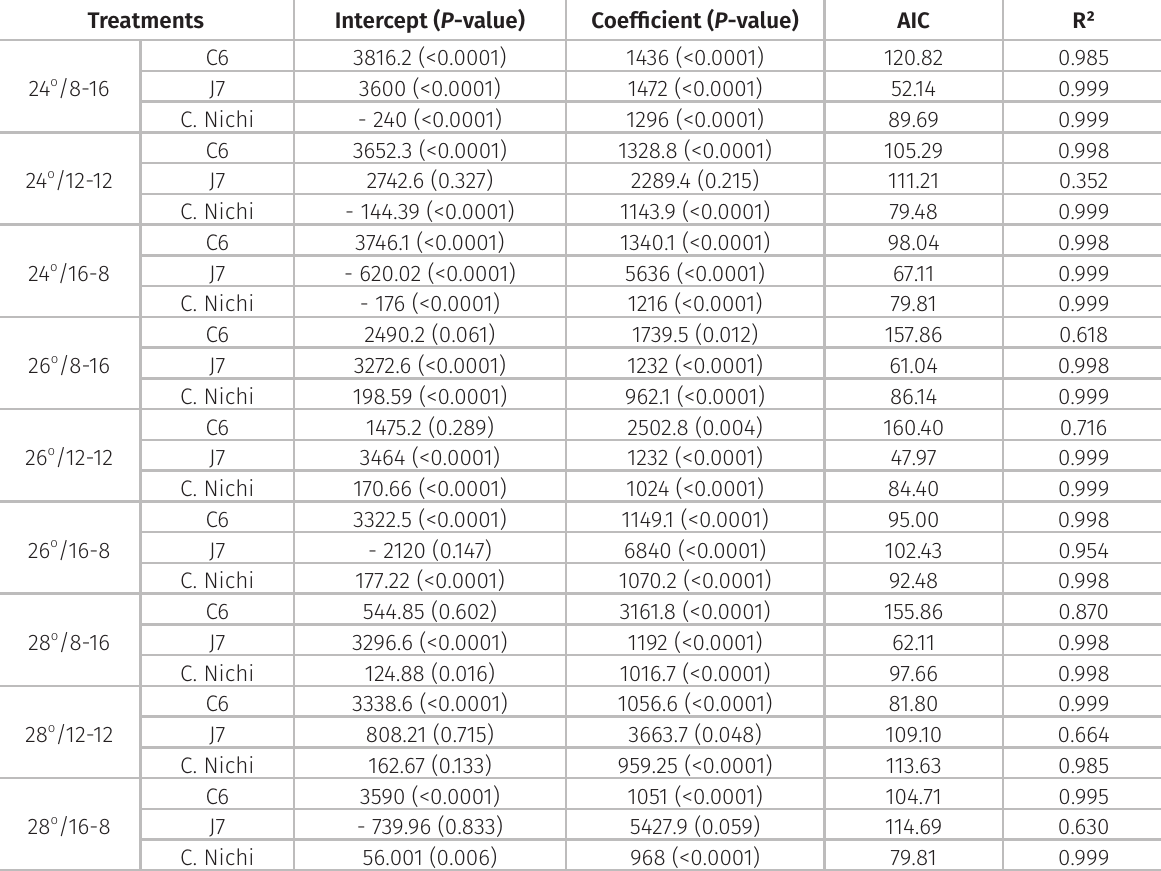
Table III. Regression equations for estimating the number of generations per year of the three lines and the coefficient of determination obtained in each case (R²). Variable predicted = total hours per year, x = number of generations. AIC: Akaike information